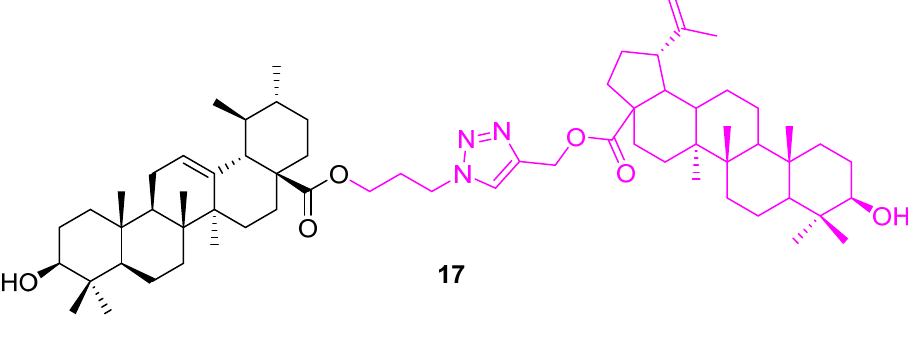
Figure 12. Structure of 17 .